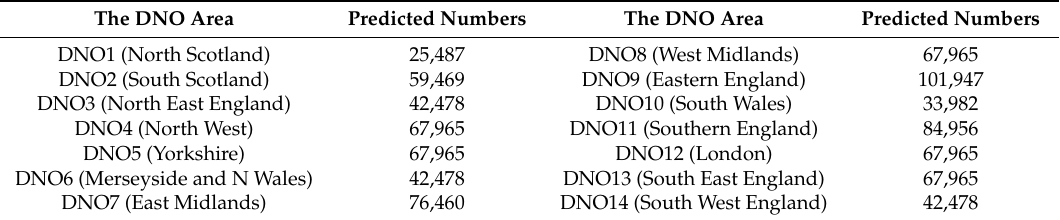
Table 3. The predicted numbers of the DHPs for each distribution network operator (DNO) area in the UK by 2035 (i.e., using the low scenario of Table